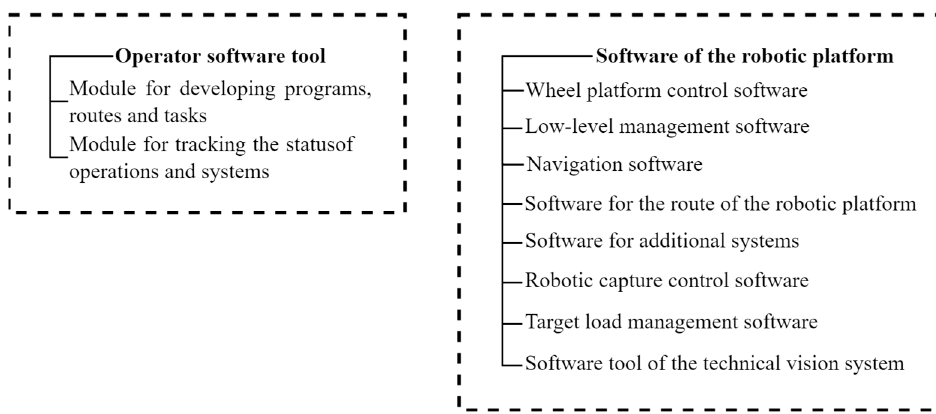
Figure 5. Elements of the robotic platform software.